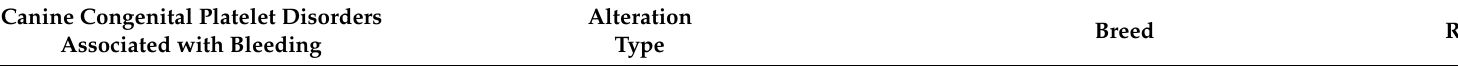
Table 2. Canine inherited platelet